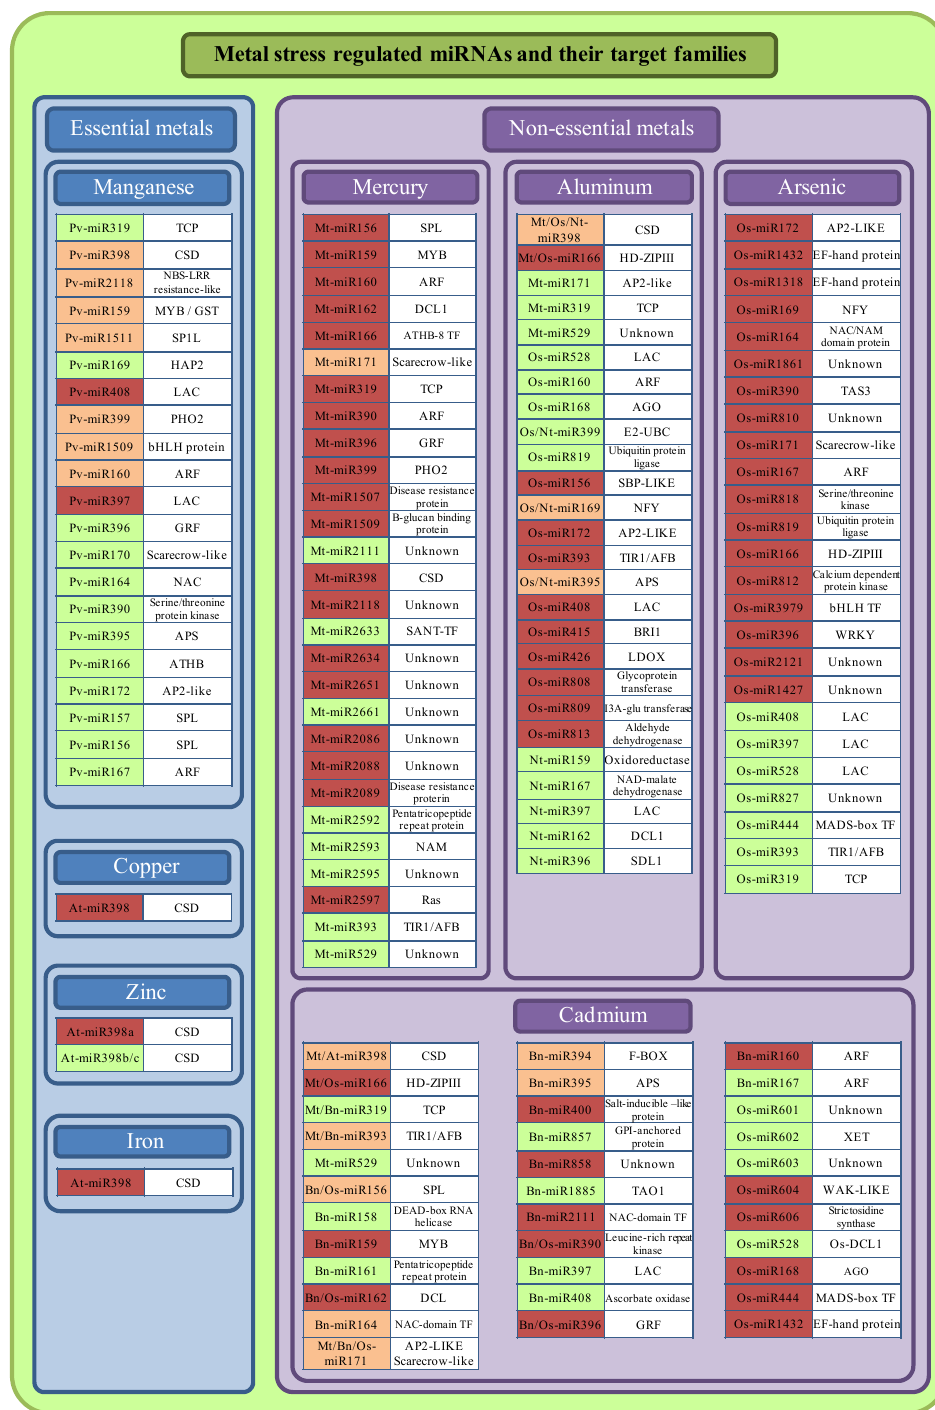
Figure 2. Summary of metal-regulated miRNAs in plants and their target families. MicroRNAs are categorized based on the metal they respond to. The effects of excess essential (Cu, Mn, Zn and Fe; blue boxes) and non-essential (Cd, Al, Hg and As; purple boxes) metals on the expression of miRNAs is shown (green: up-regulation; red: down-regulation; orange: up-regulation or down-regulation through contrasting results in various studies.). These metal-regulated miRNAs are obtained from several plant species, like Arabidopsis thaliana (At), Phaseolus vulgaris (Pv), Medicago truncatula (Mt), Brassica napus (Bn), Oryza sativa (Os) and Nicotiana tabacum (Nt)